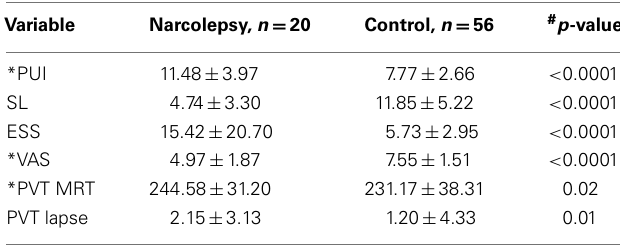
Table 1 | Descriptive statistics and differences in measures between Table 2 | Selected group-wise Pearson correlation coefficients